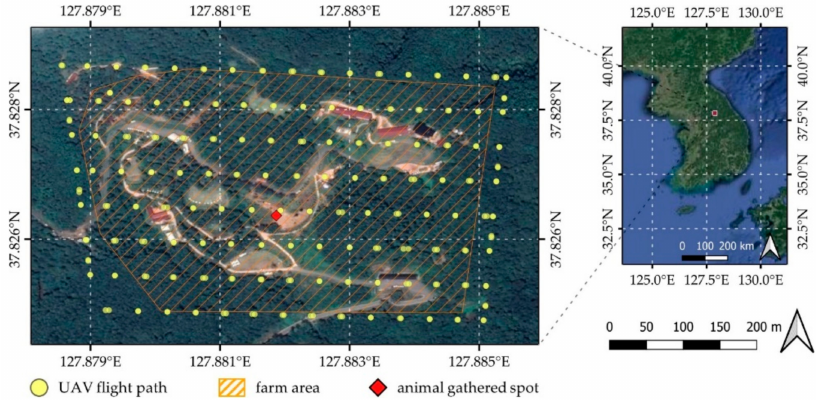
Figure 1. Overview of the study